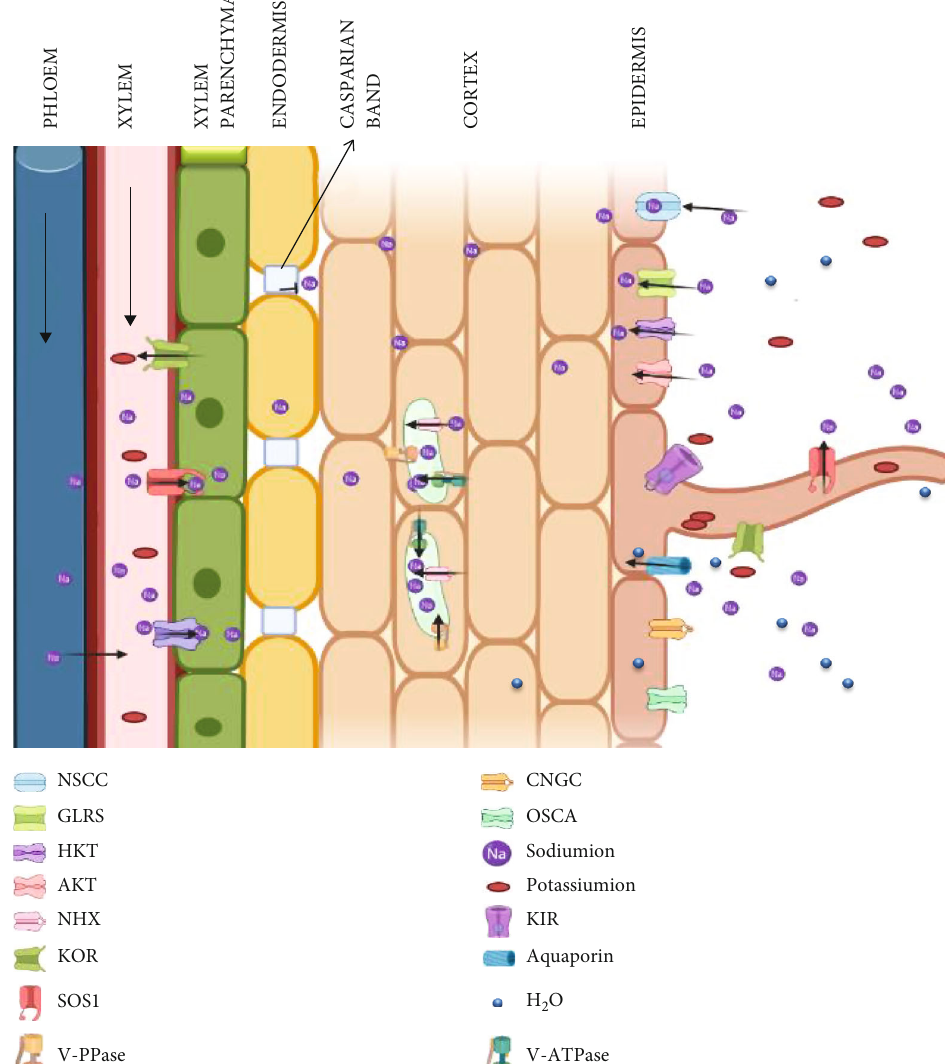
Figure 1: Schematic representation of Na + and K + transporters mediating Na + and K + homeostasis in plant roots under salt stress. Na + ions enter the cells via nonselective cation channels (NSCCs) and possibly via other cation transporters (symplast fl ow) and intercellular spaces (apoplast fl ow). The SOS1 extrudes Na + at the root-soil interface and the xylem parenchyma cells. Likewise, HKT also retrieves Na + from the xylem. SOS1, localized in the xylem parenchyma cells, mediate Na + e ffl ux from xylem vessels under high salinity. Excessive Na + in root is sequestered in the large central vacuole by tonoplast-localized NHX exchangers, V-ATPase, and V-PPase which also generate electrochemical potential gradient for secondary active